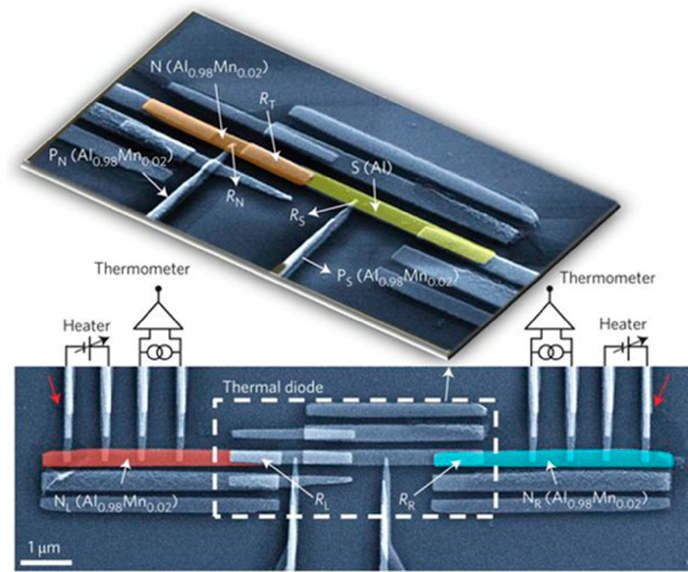
Figure 11. False-color SEM image of the thermal rectification device. Reprinted with permission from Springer Nature Publishing Group.